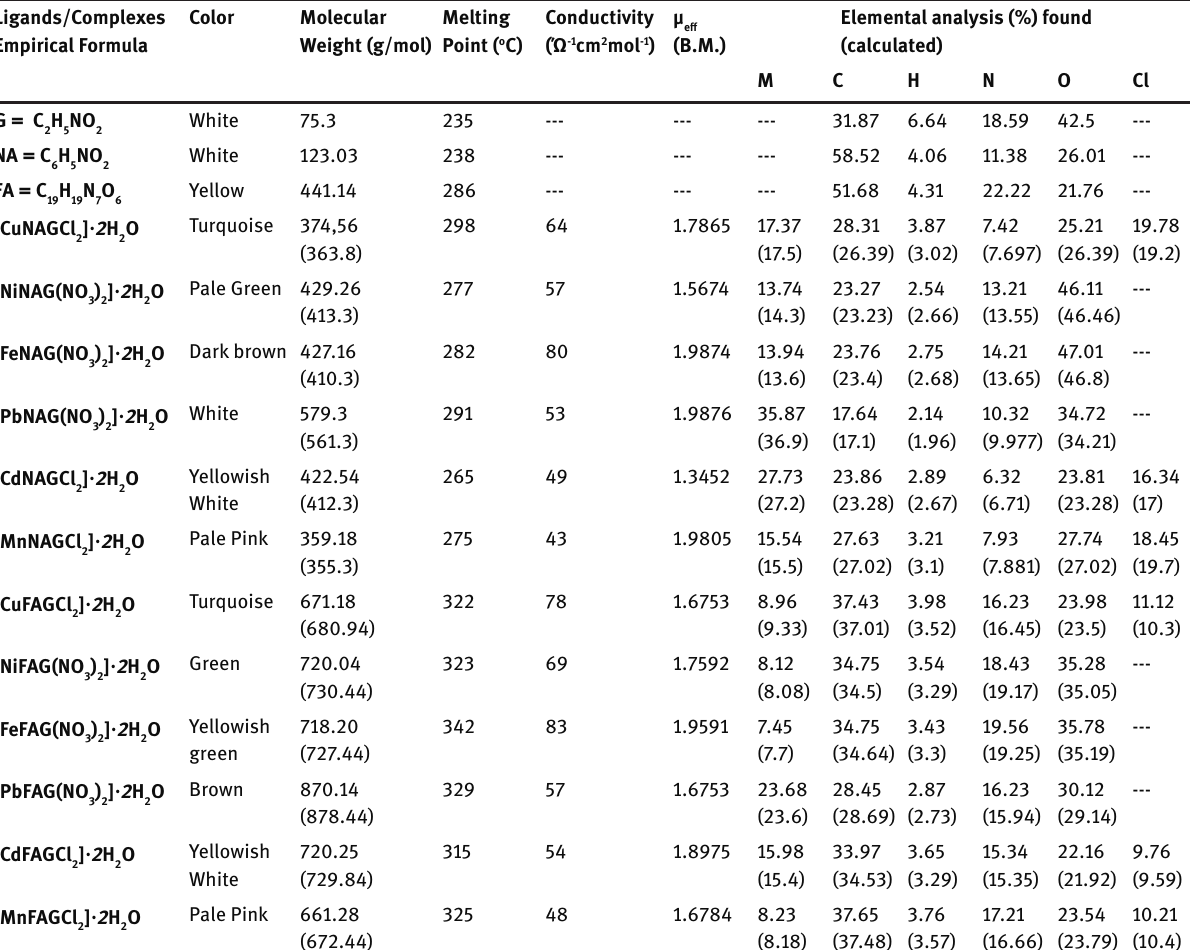
Table 1: Analytical and physicochemical data (color, melting point, elemental analysis, and molar conductance value) of mixed glycine (G) – vitamin (NA/FA) – metal drug